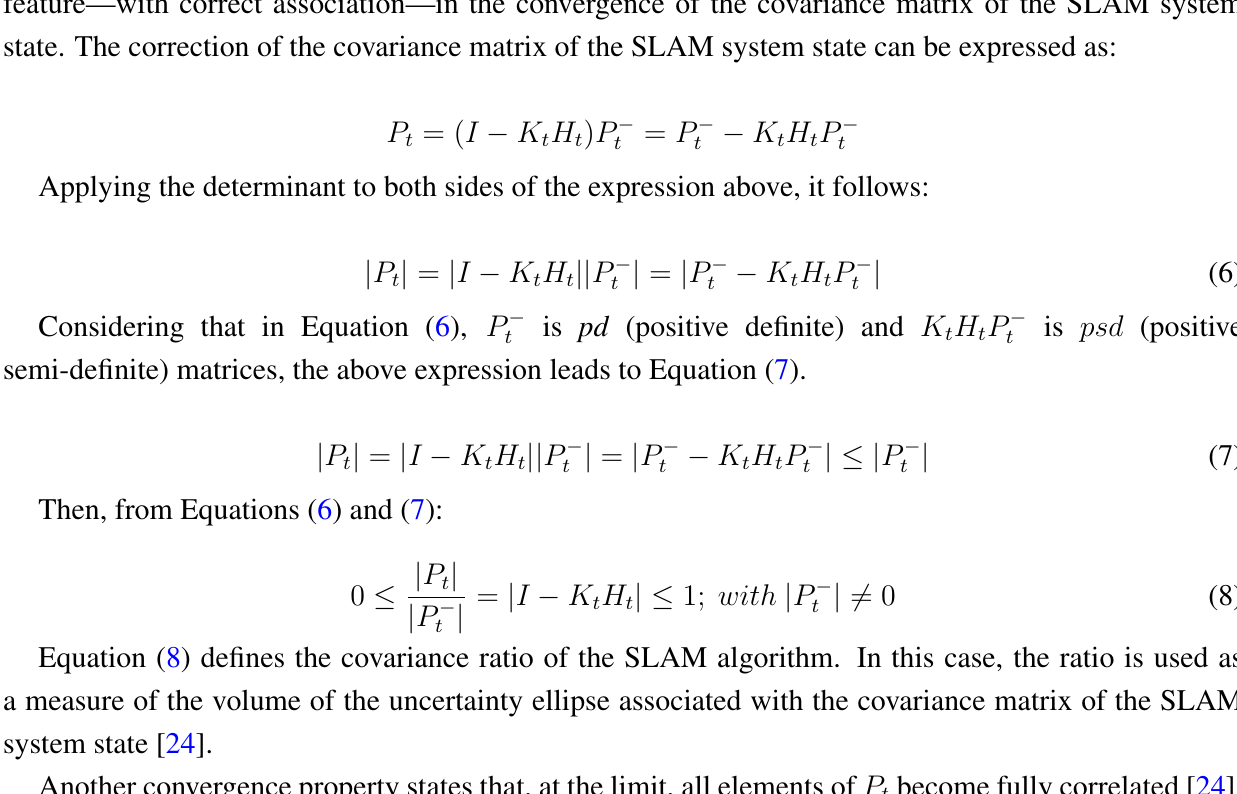
Algorithm of the EKF-SLAM based on the entropy feature